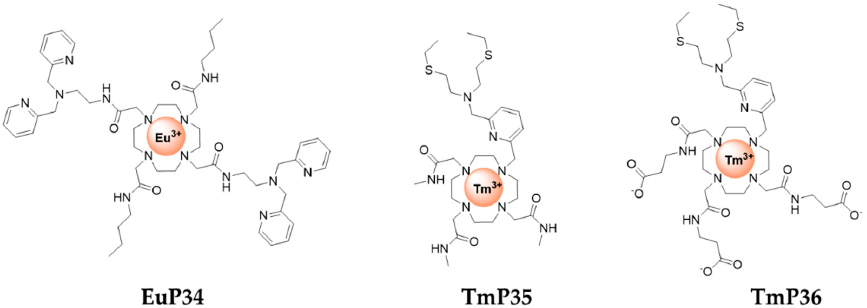
Figure 8. Bioinspired zinc finger peptide and principle for zinc detection by Magnetic resonance imaging (MRI): ( A ) Structure of bioinspired zinc-finger peptide LnLZF2 ; ( B ) Representation of the folding of LnLZF2 upon Zn 2+ binding; ( C ) T 1 -weighted MR images of phantoms containing Zn-free